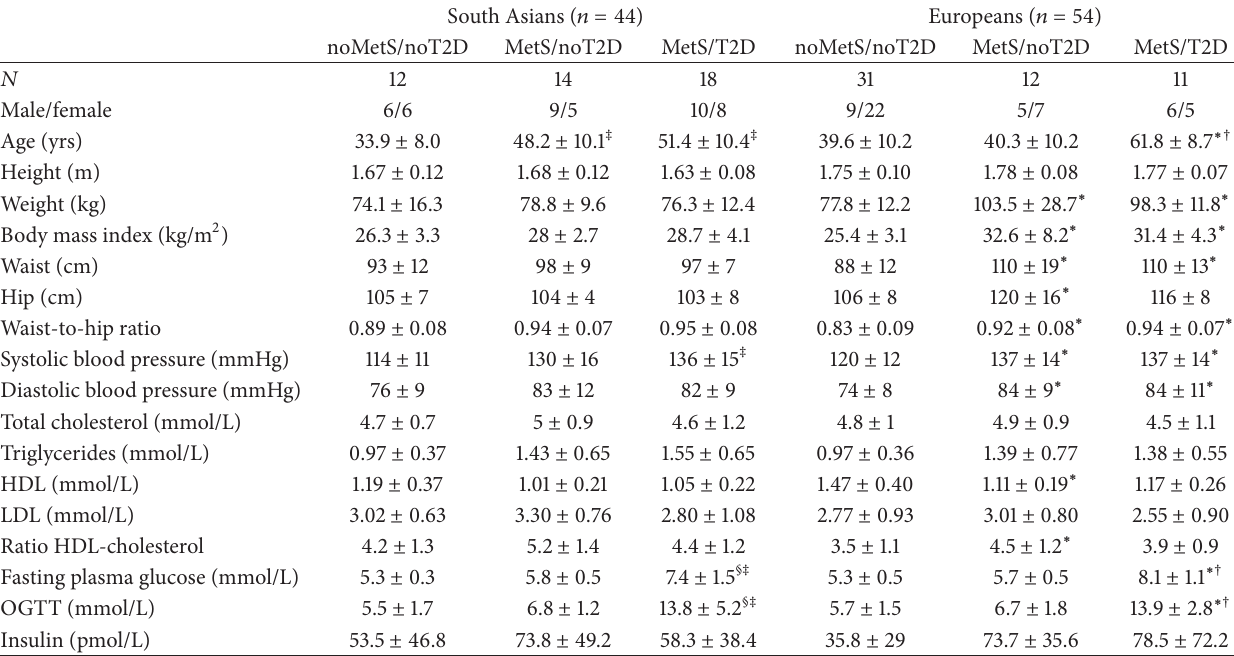
Table 1: General characteristics of the study subjects.